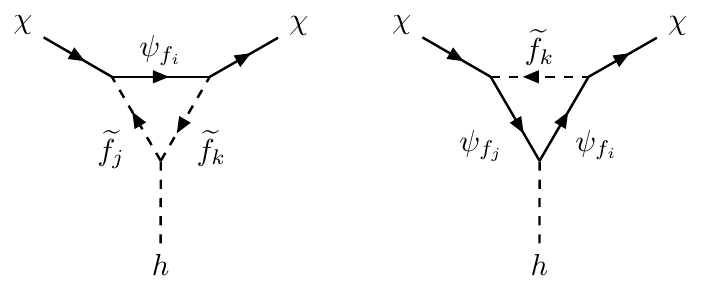
Figure 3 . Feynman diagrams for e(cid:11)ective DM-Higgs interactions.